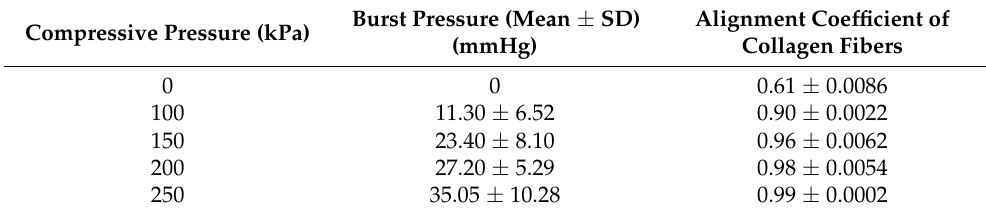
Table 1. Burst pressure and alignment coefficient of fused small intestines at varying